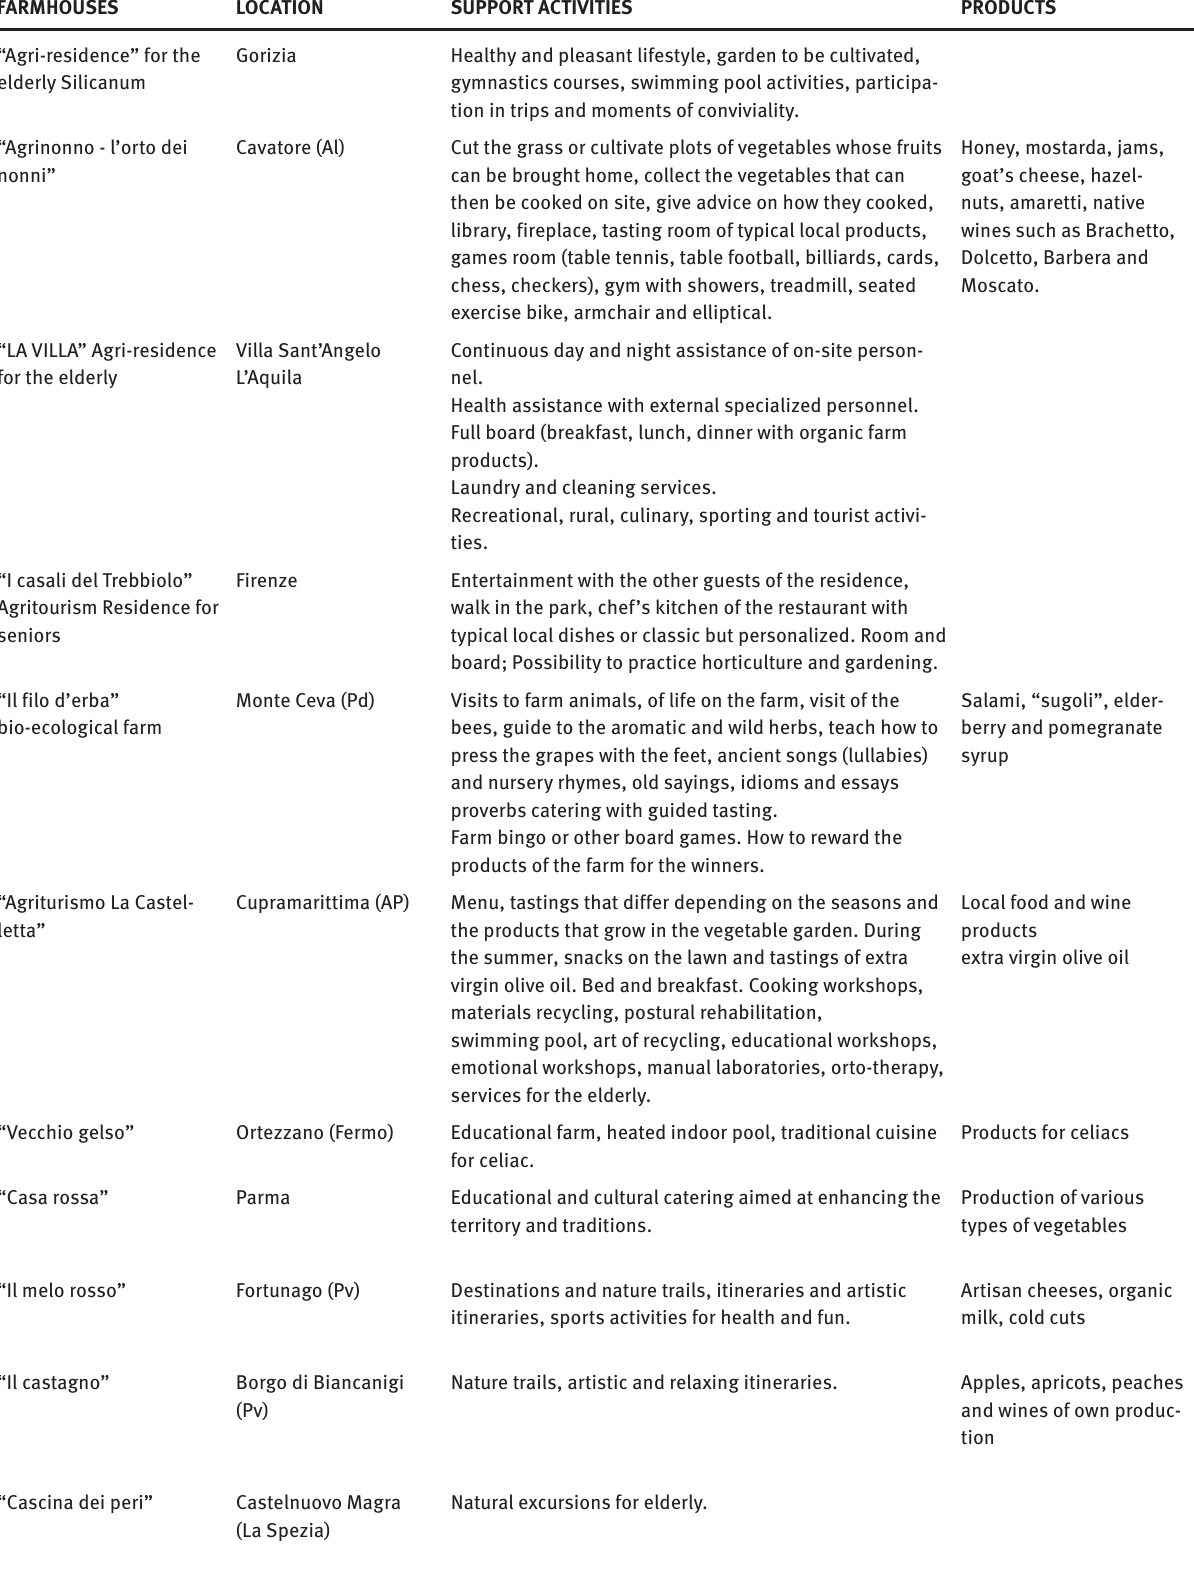
Table 1: Farmhouses listed according to geographical locations, individual support activities supplied and available products